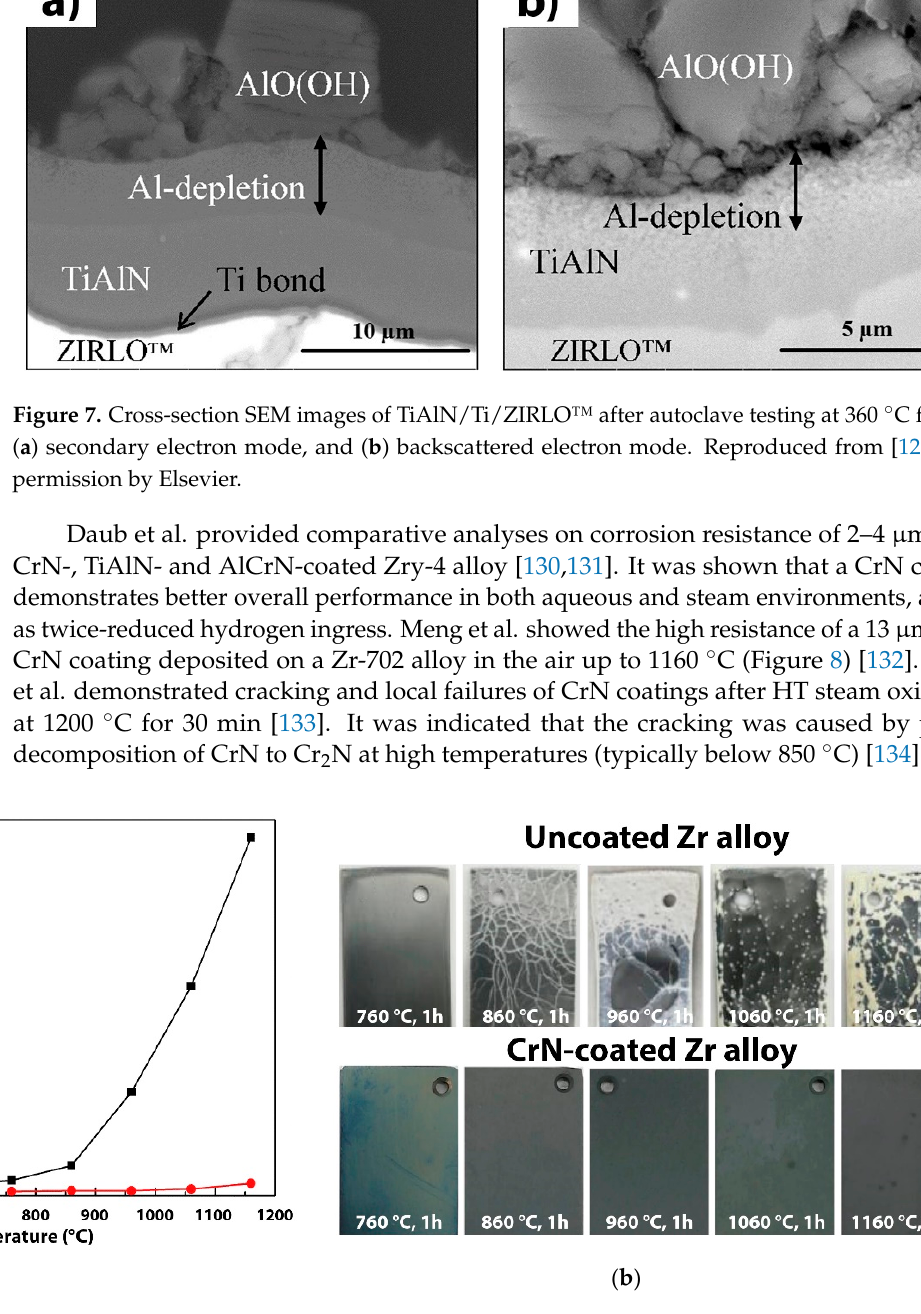
Figure 8. Weight gain of uncoated and CrN-coated Zr alloys as the function of oxidation temperature in the air ( a ), and the appearance of the samples after the oxidation tests ( b ). Reproduced from [ 132 ] with permission by Elsevier.